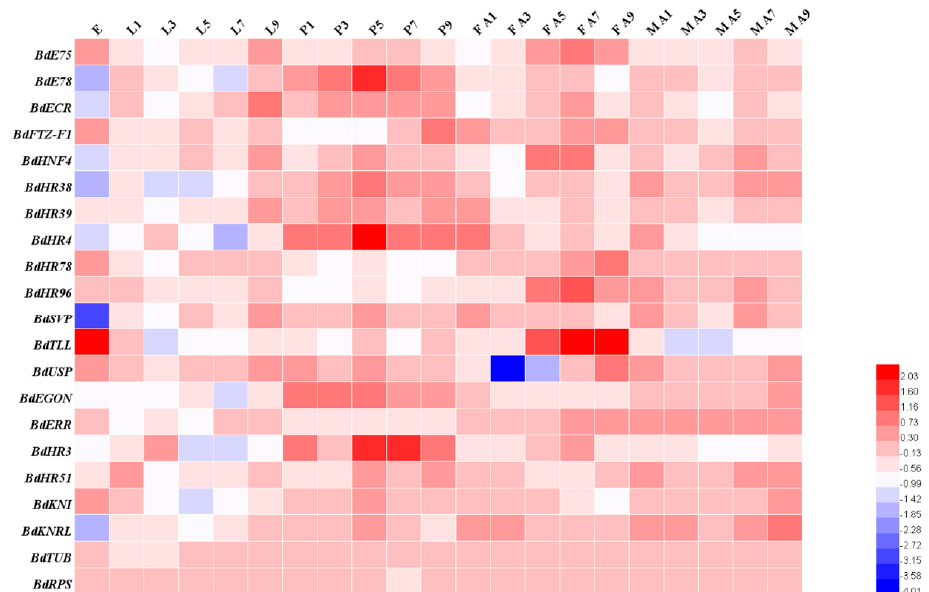
Figure 3. Developmental mRNA expression profiles of 19 B. dorsalis NR genes (excluding BdHR83 and BdDSF ) . Relative transcript levels were calculated using α -tubulin (GenBank Accession no.: